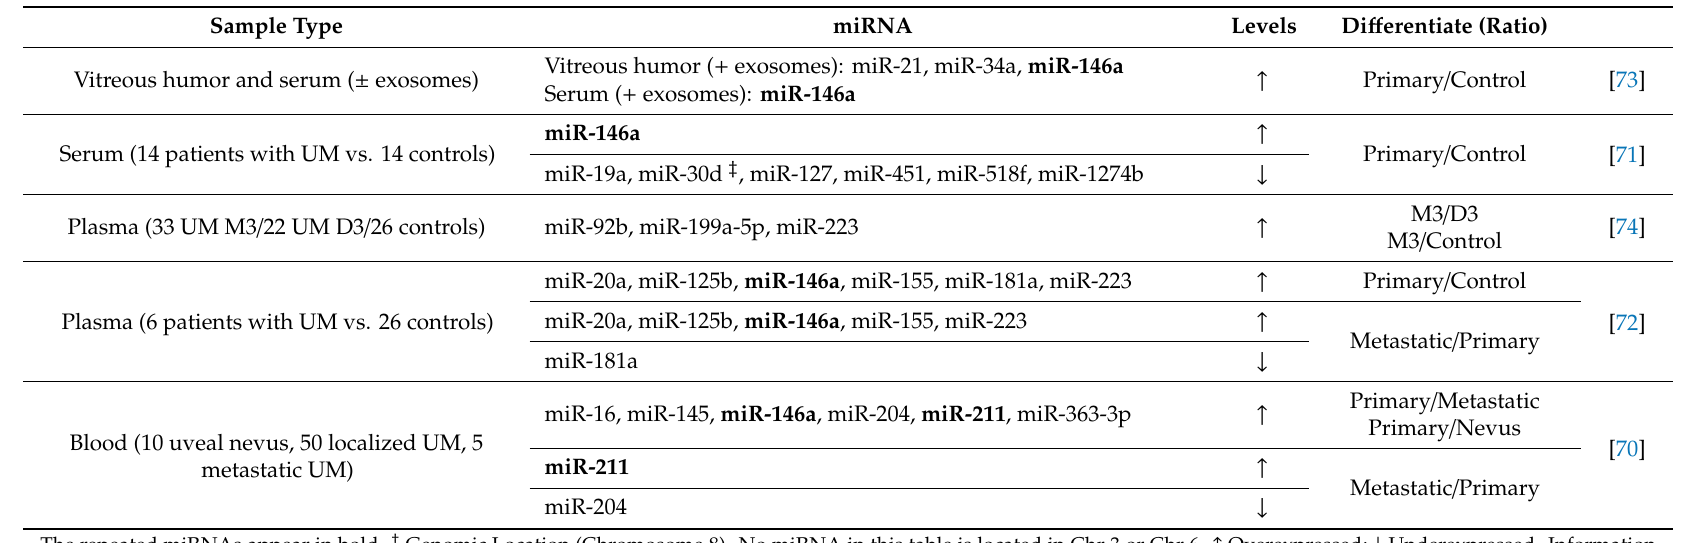
Table 4. Circulating MicroRNAs as potential biomarkers in